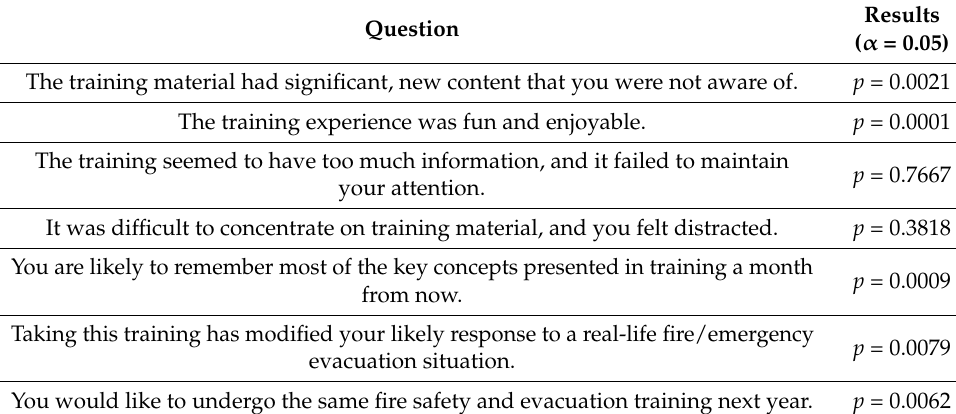
Table 2. Perception of participants on SBST vs. VSW. Question